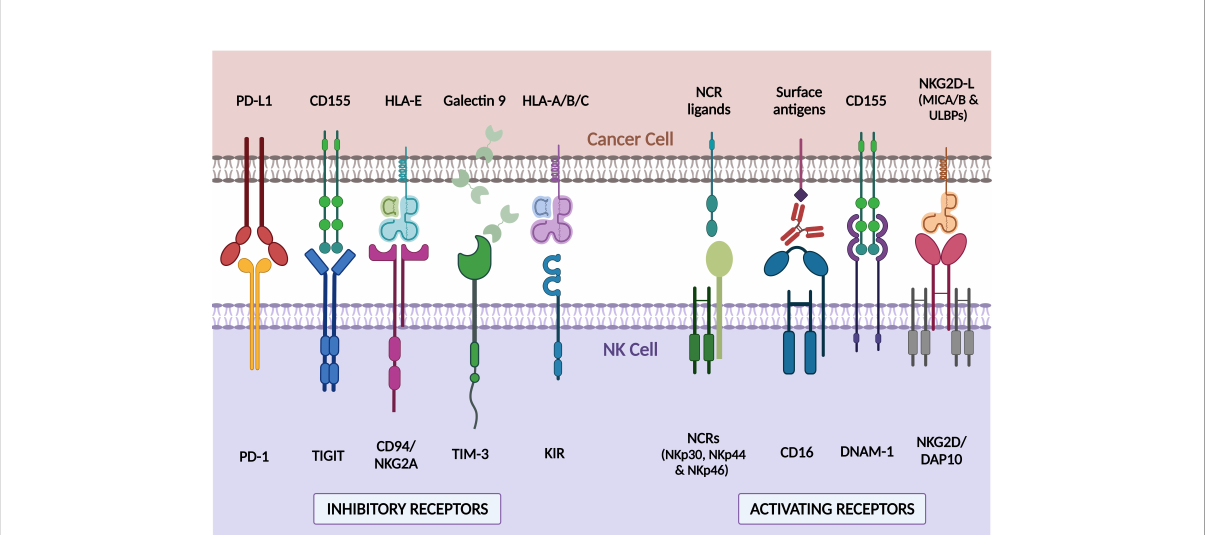
FIGURE 1 Major endogenous NK cell receptors and their associated ligands in tumor cells. NK cell function is modulated through different surface receptors which bind to ligands expressed on cancer cells. Receptors such as NCR (NKp30, NKp44, and NKp46), CD16, DNAM-1, or NKG2D/ DAP10 trigger an activating NK signaling that results in a potent cytotoxic response against ligand-expressing cells. On the contrary, other receptors like PD-1, TIGIT, CD94/NKG2A, TIM-3, and KIRs, turn off NK response when bind to their cognate ligands. The combination of positive and negative signals regulates NK cell response to target cells. PD-1, Programmed Death 1; TIGIT, T cell immunoglobulin and ITIM domain; TIM- 3, T cell immunoglobulin and mucin-domain containing-3; KIR, Killer-cell immunoglobulin-like receptor; NCRs, natural cytotoxicity receptors; DNAM-1, DNAX accessory molecule; NKG2D/DAP10, natural killer group 2D/DNAX-activation protein 10; PD-L1, Programmed Death ligand-1; HLA-E, HLA class I histocompatibility antigen, alpha chain E; HLA-A/B/C, HLA class I histocompatibility antigen, alpha chain A/B/C; NKG2D-L, NKG2D ligands; MICA/B, MHC class I polypeptide-related sequence A/B; ULBPs, UL16 binding proteins. Created with